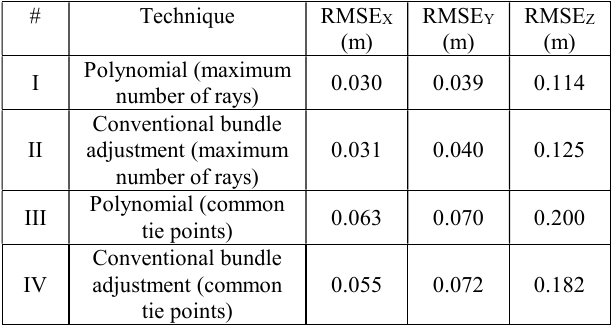
Table 2. RMSE resulting from the